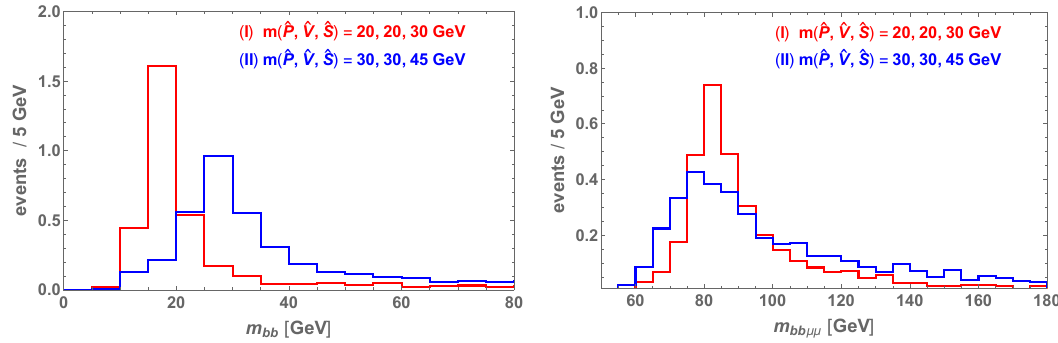
Figure 2 . Distributions of the b (cid:22) b invariant mass ( left ) and total invariant mass of the b (cid:22) b(cid:22)(cid:22) system ( right ) for the Z ! ^ P ^ S ! b (cid:22) b(cid:22)(cid:22) + X signal at the 13 TeV LHC, after the basic selection of eq. (4.1). The normalization corresponds to f ^ = 1 and M = 2 TeV. The integrated luminosity is set to P ^ S L = 35 : 9 fb (cid:0) 1 as in ref.